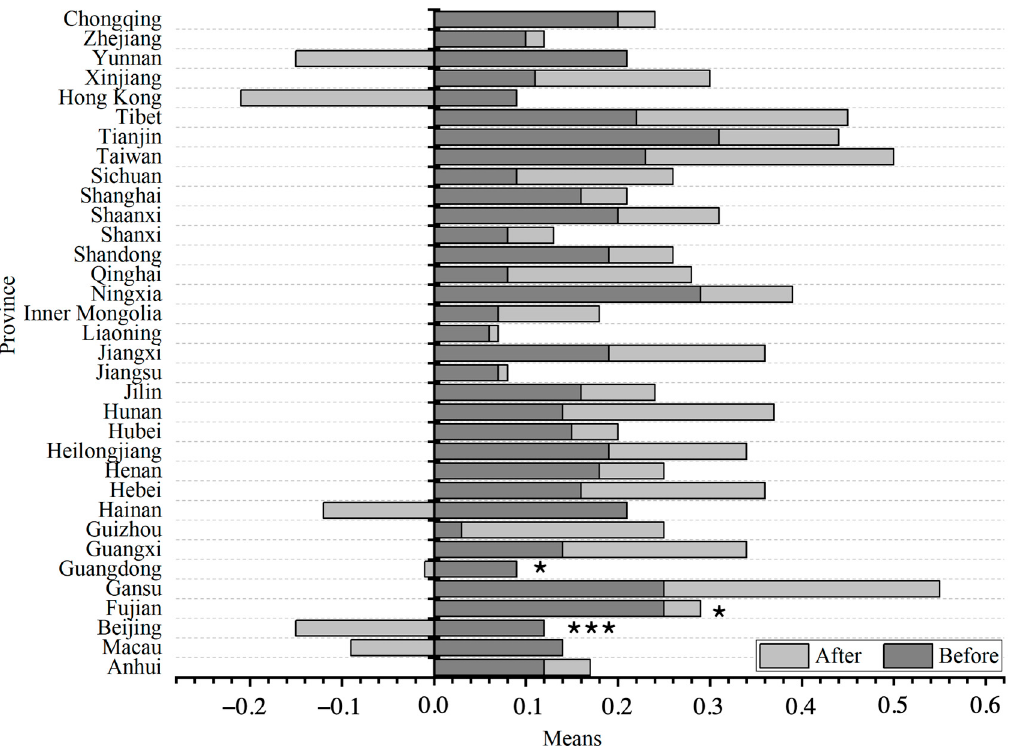
Figure 4. Temporal and spatial differences in support intention before and after release-type com-